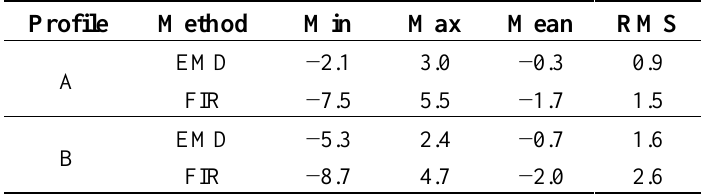
Table 1. Statistics of the differences for internal consistency (units: mGal).